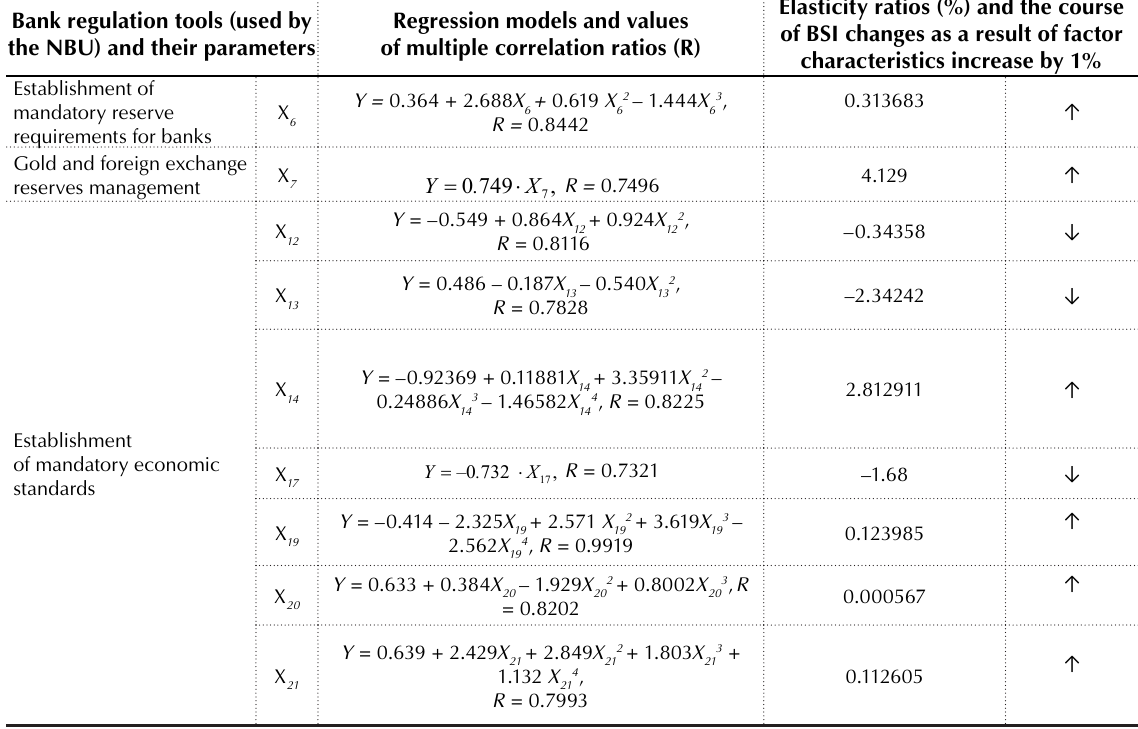
Table 4 (cont.). Substantiating the most effective bank regulation tools based on the influence on the level of Ukrainian banking system stability Bank regulation tools (used